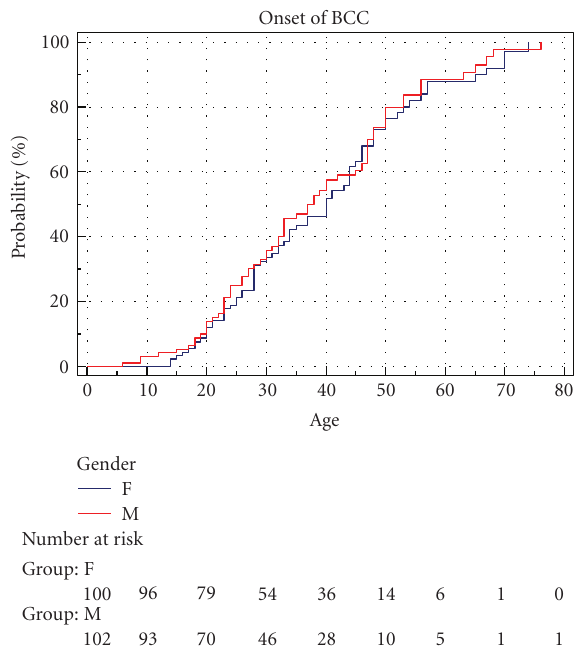
Figure 1: Cumulative onset of BCC by gender. Male(m) n = 100. Female (f) n = 102.